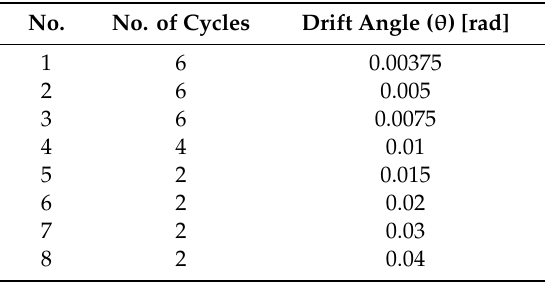
Table 2. Tensile coupon specimen properties. Table 3. Load protocol of tests and finite element model